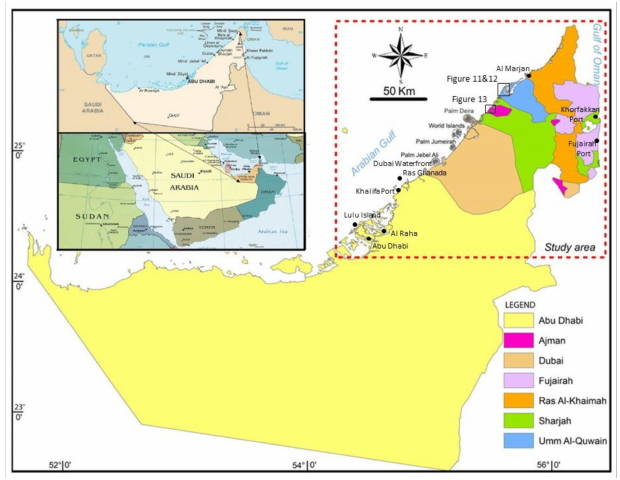
Figure 1. Location map of the study area showing the important reclaimed areas in the